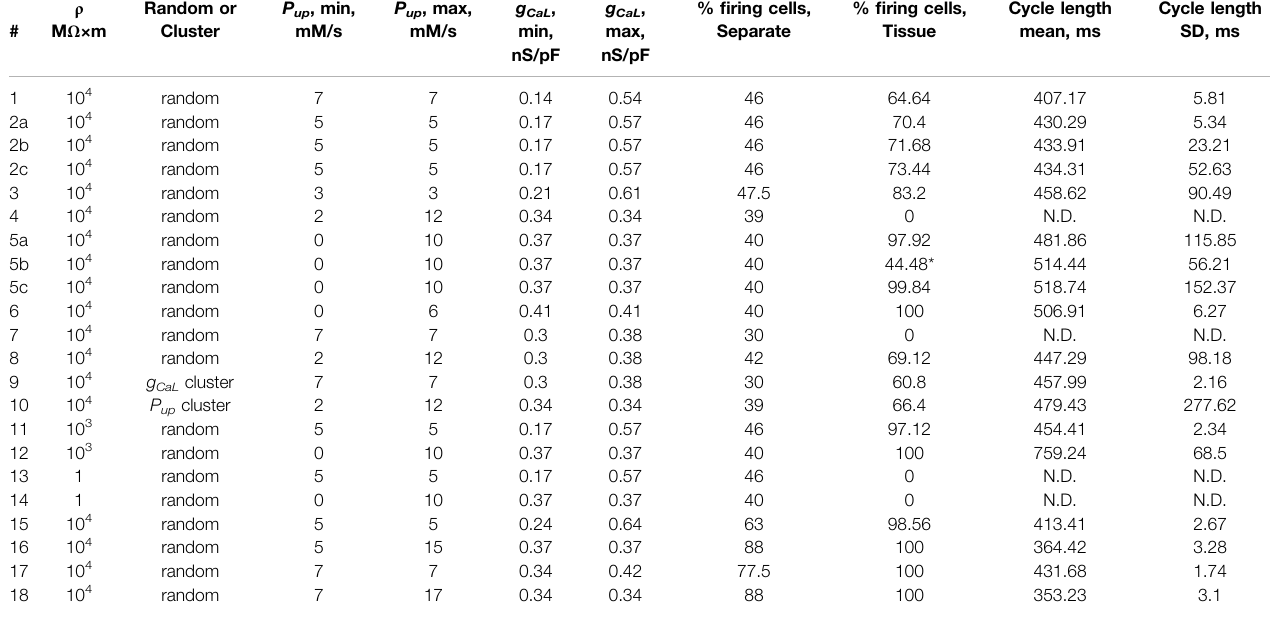
TABLE 1| Parametervaluesineach modelsimulationscenario (column#)and resultsofoursimulationsduringevaluationtime interval from5to7.5 safter simulationonset: the percentage of AP fi ring cells in tissue, the percentage of cells fi ring APs in isolation, and AP cycle length average with its standard deviation (SD) calculated for all AP